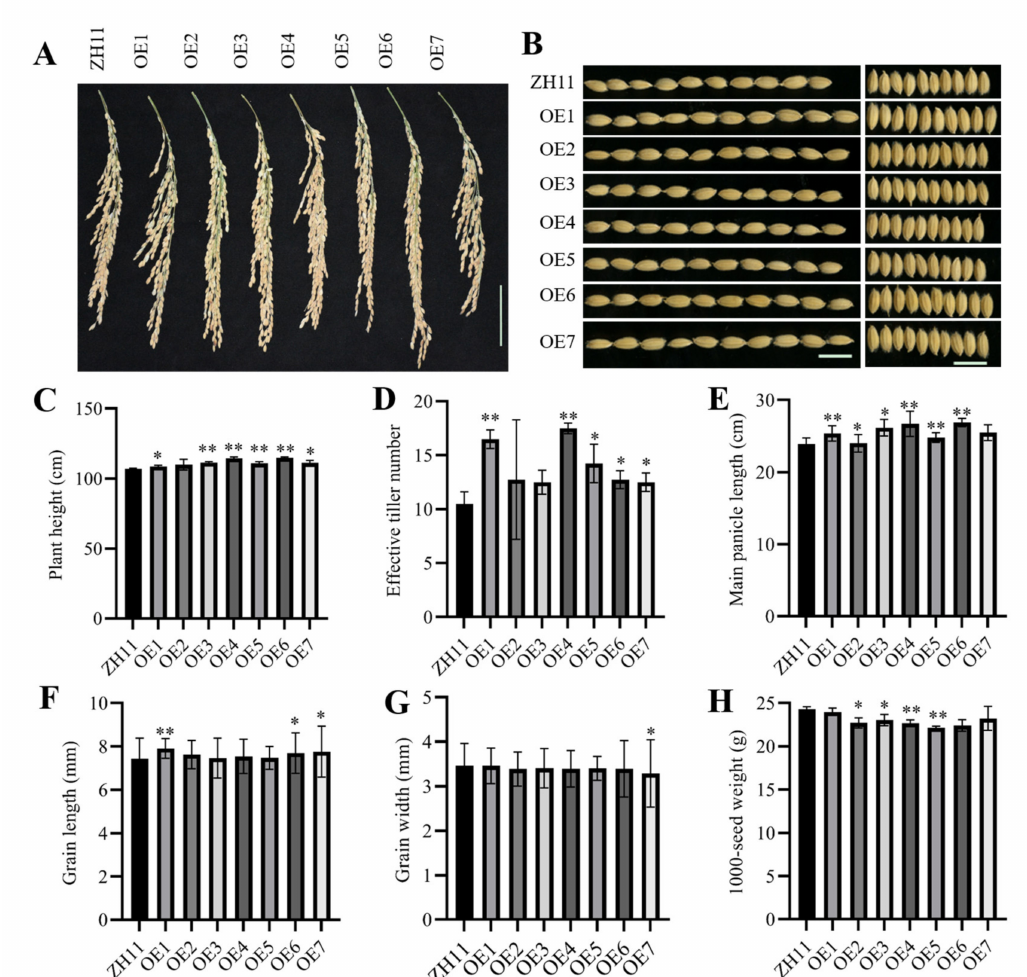
Figure 5. Overexpression of ZmHsf05 in rice alters agronomical traits in field trials. Wild-type rice variety ZH11 (Zhonghua 11) and seven independent transgenic rice lines were used (OE1, OE2, OE3, OE4, OE5, OE6 and OE7). ( A ) Mature ZH11 and transgenic rice panicles. (Scale bar, 5 cm.) ( B ) Seed length (left panel), and seed width (right panel) for ten seeds in a row (Scale bar, 1 cm.). ( C ) Plant height ( n = 5). ( D ) Effective tiller number ( n = 5). ( E ) Main panicle length ( n = 5). ( F ) Grain length ( n = 90). ( G ) Grain width ( n = 95). ( H ) 1000-seed weight ( n = 3) were evaluated for overexpression transgenic lines and wild-type plants, respectively. Students’ t -test was performed for statistics analysis, * denotes p < 0.05, ** denotes for p < 0.01, n represents the number of repetitions that have been